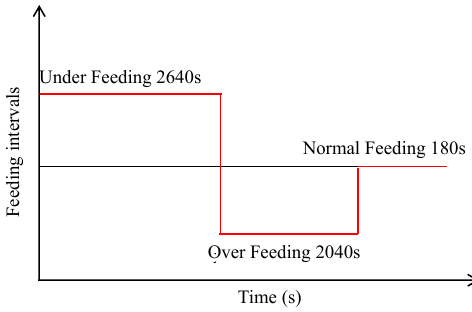
Figure 2. Typical underfeeding, overfeeding, and normal feeding cycle of a 500 kA cell.